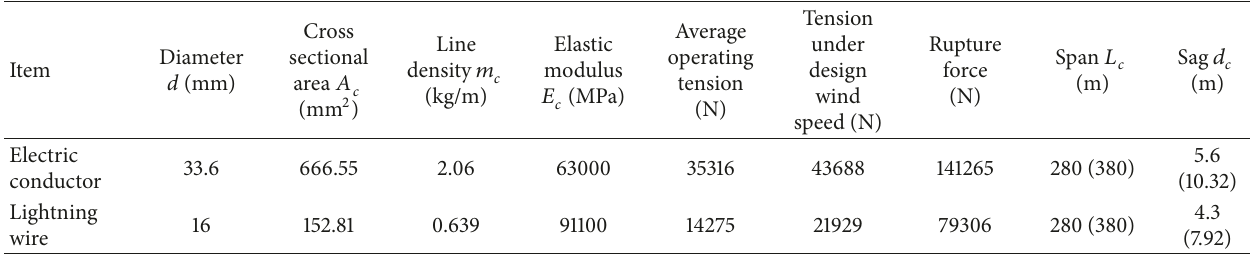
Table 2: Design parameters of the transmission lines.